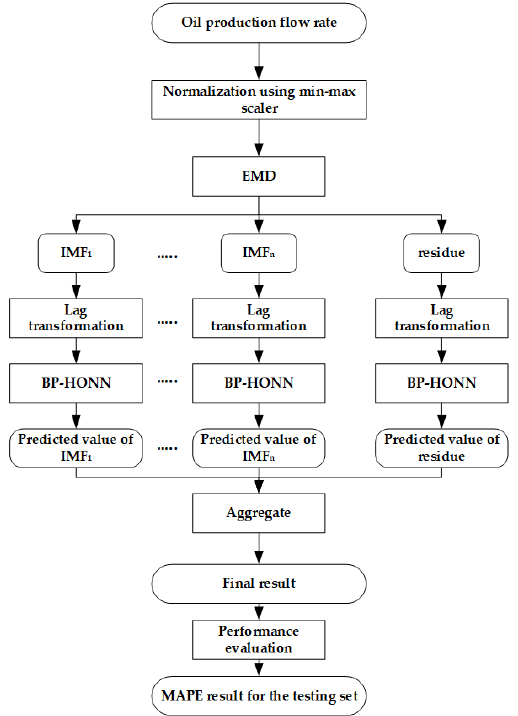
Figure 4. Proposed model of EMD-BP-HONN.